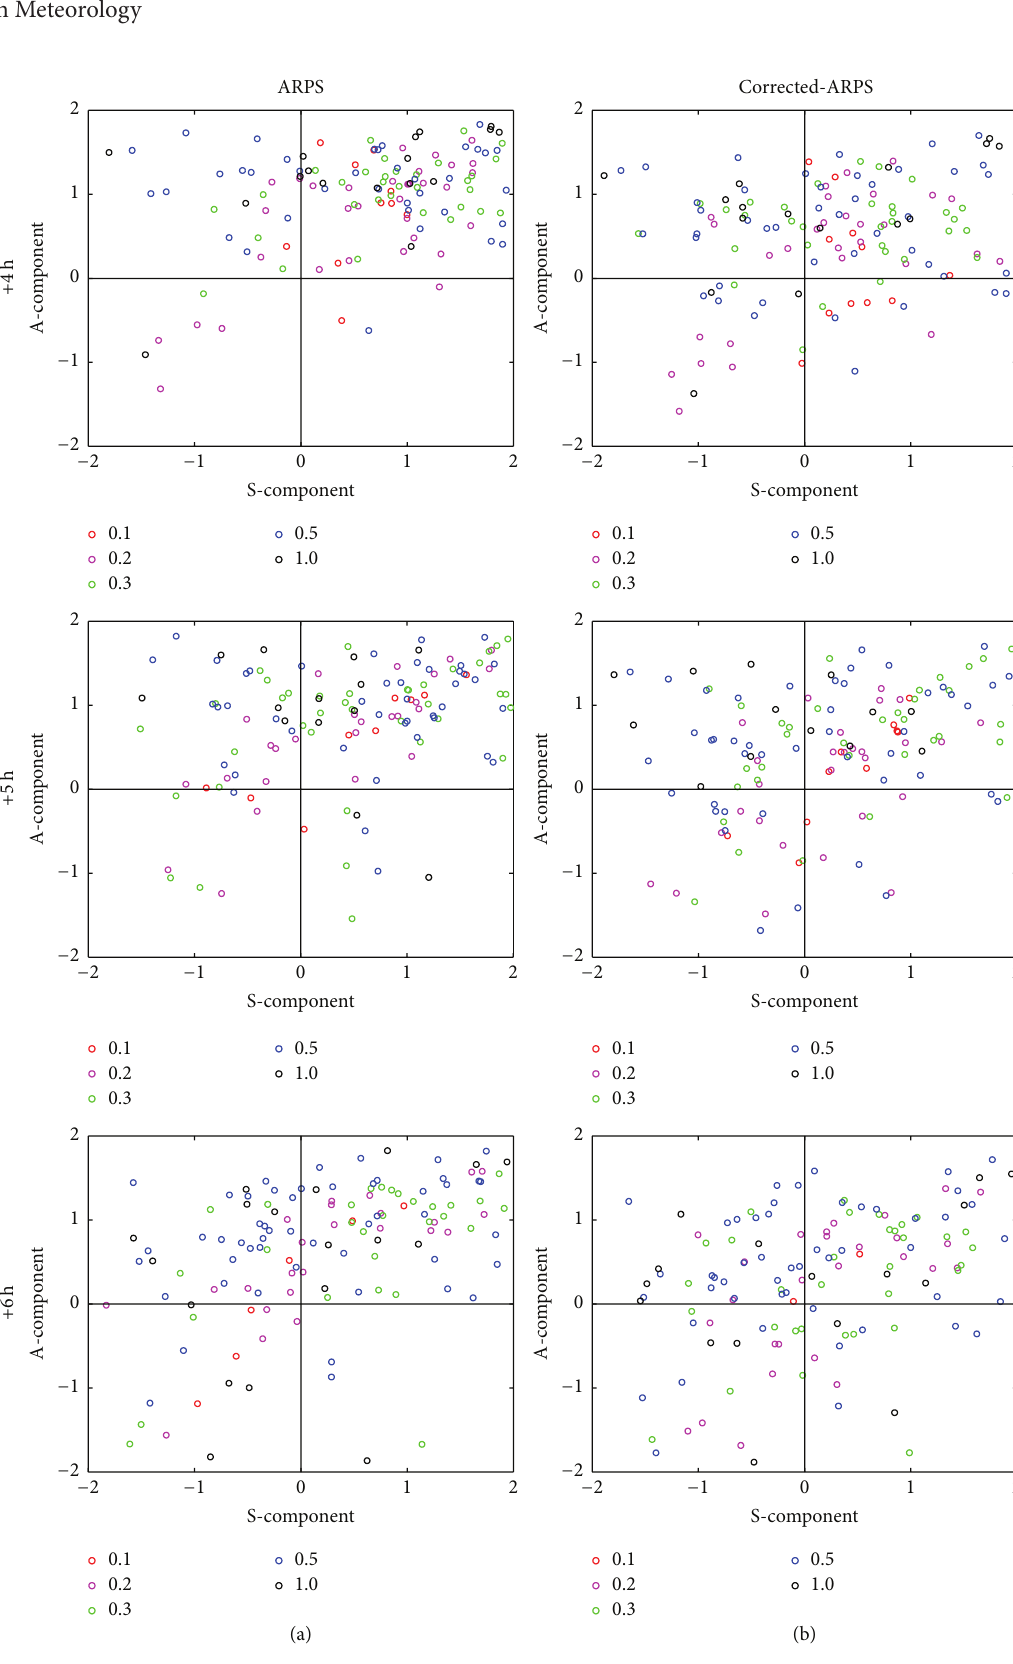
Figure 6: SAL diagrams for the hourly precipitation forecasts of the original (a) and the corrected (b) ARPS for lead times from 1h to 6 h. Every circle indicates three components of SAL for a forecast. The L component is shown by the color of the